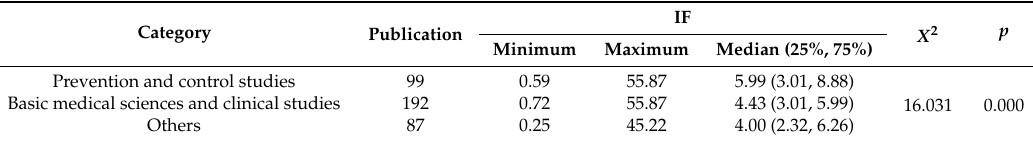
Table 7. Impact factors across research